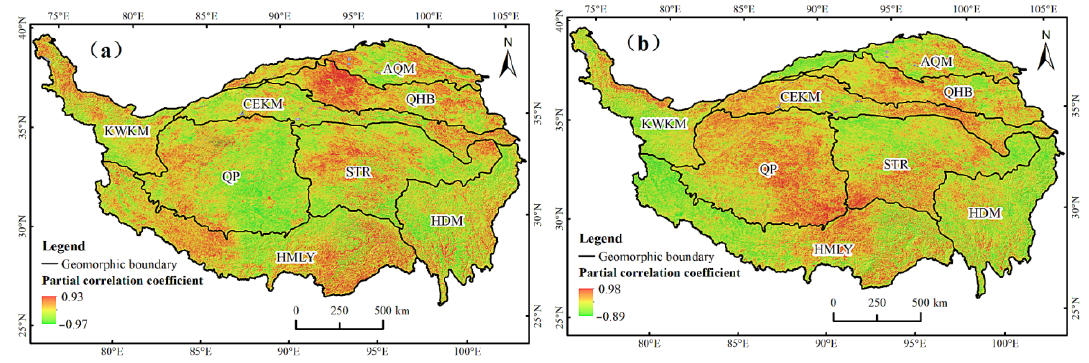
Figure 12. The distribution of partial correlation coefficients between TVDI and annual precipitation ( a ) and annual average temperature ( b ).